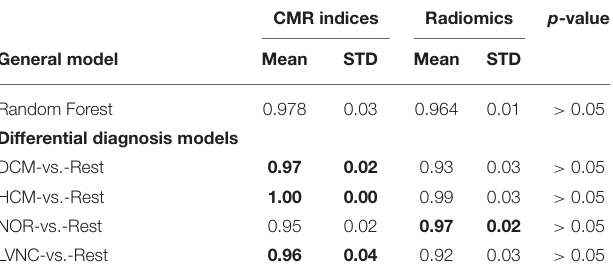
TABLE 5 | Generic and differential diagnosis AUC testing metrics for Random Forest model.